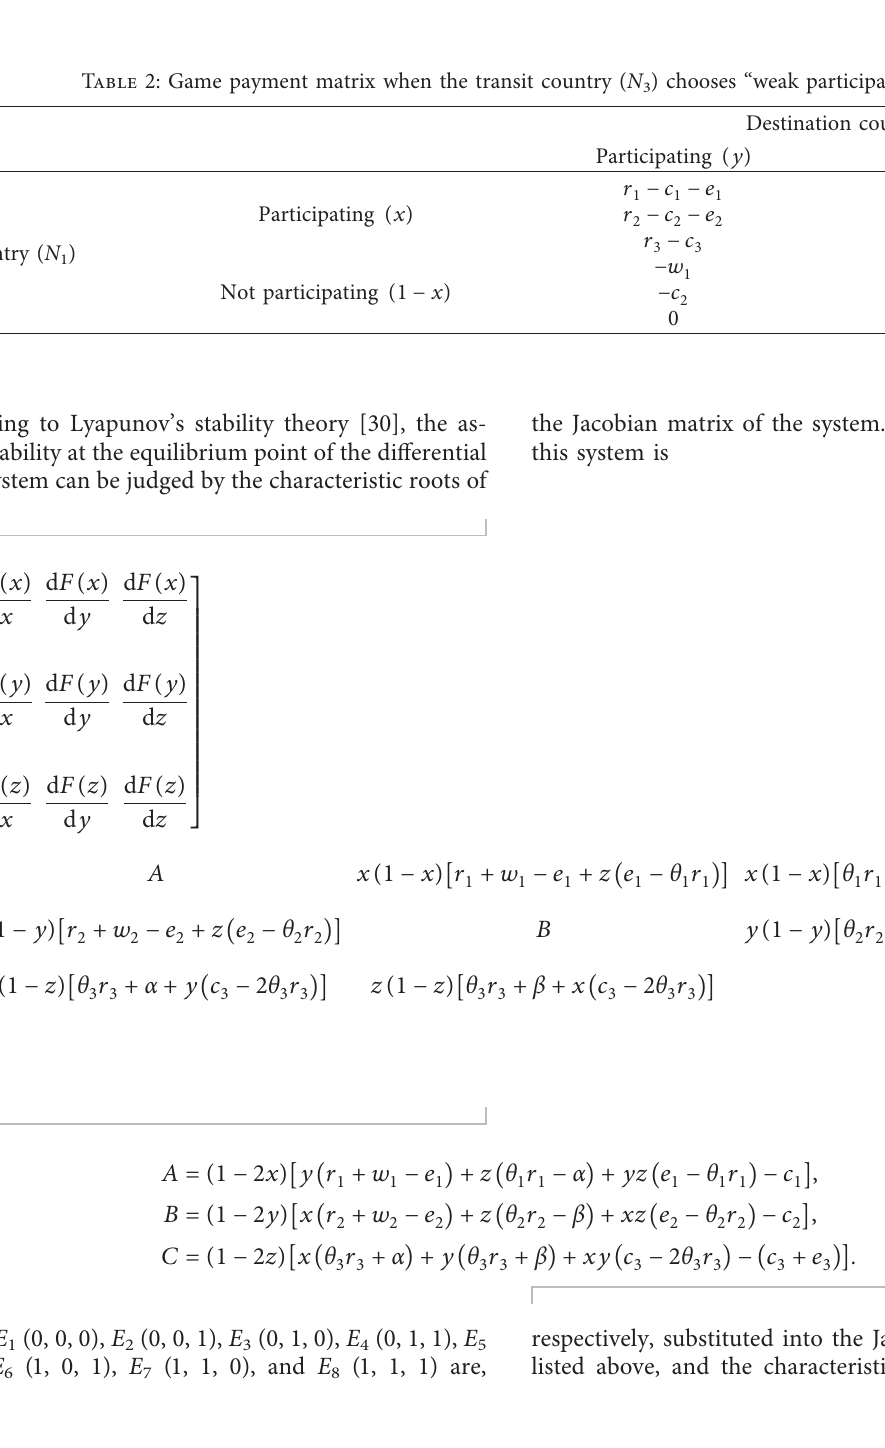
Table 2: Game payment matrix when the transit country ( N